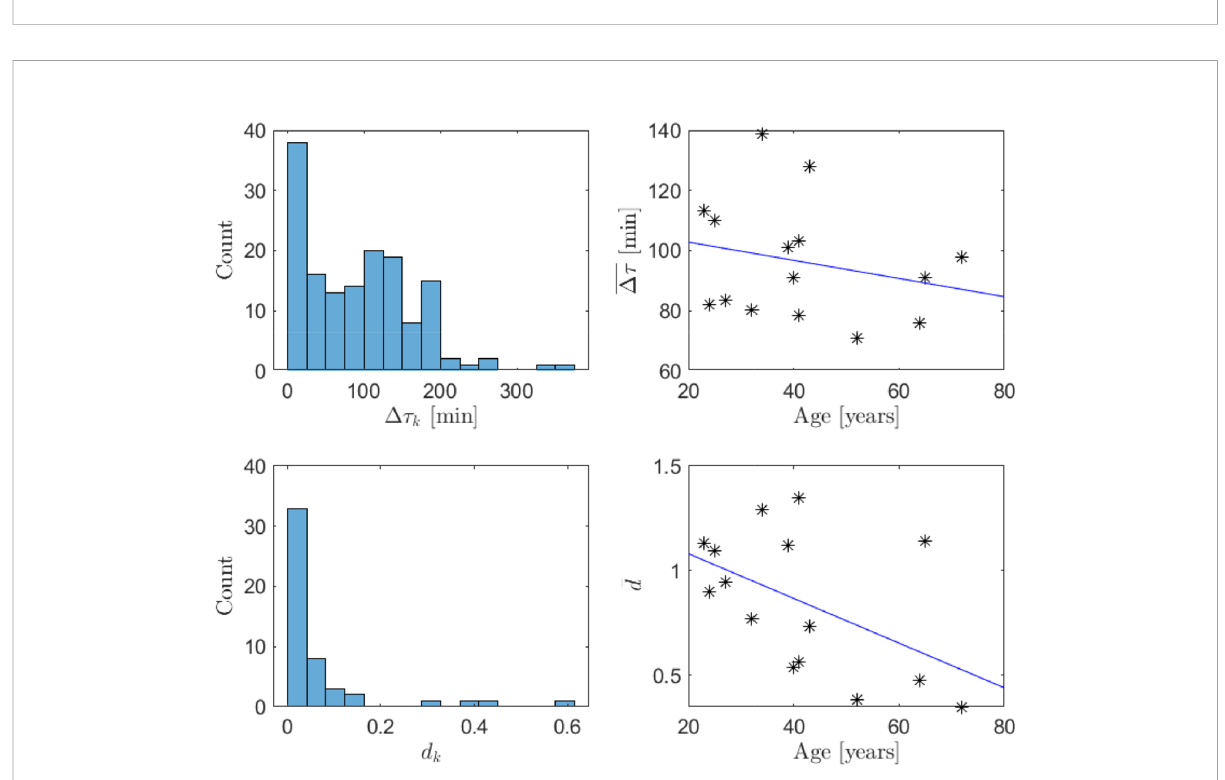
FIGURE 10 Histograms of impulse time separation (top left) and impulse weight (bottom left) for all individuals and average impulse time separation (top right) and impulse weight (bottom right) depending on age (both represented with asterisks), with fi tted af fi ne functions (in blue). The dependence of impulse weights on age is statistically signi fi cant ( p =.029 ), whereas the dependence of time separation on age is not ( p